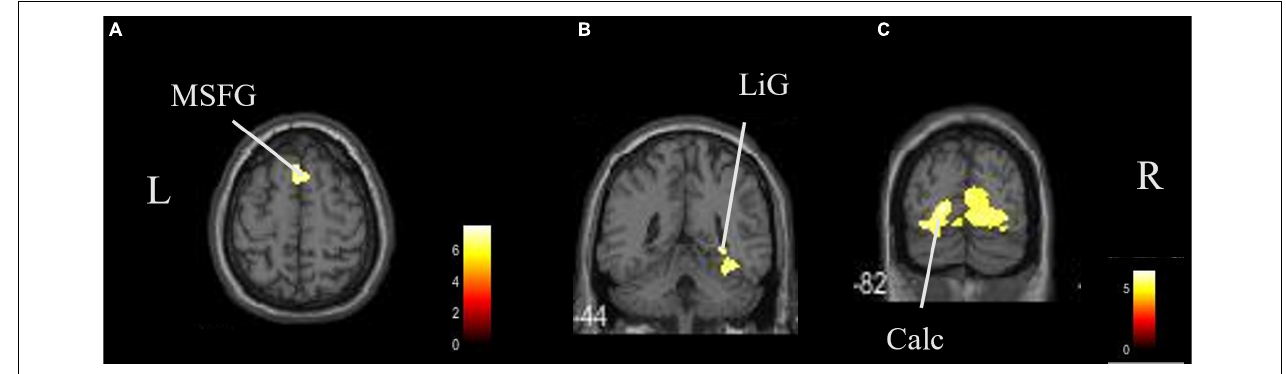
FIGURE 4 | Brain areas that were significantly more activated by ASMR stimulation than by classical music. Significantly more activation was observed in the right triangular part of the left calcarine cortex, right superior frontal gyrus medial segment, and right lingual gyrus in ASMR compared with classical music. (A) Axial view. (B,C) Coronal view. L, left; R, right. ASMR, autonomous sensory meridian response; LiG, lingual gyrus; MSFG, superior medial gyrus medial